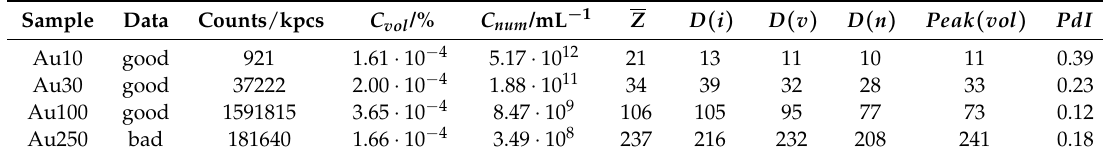
Table A5. Results from high resolution algorithm.